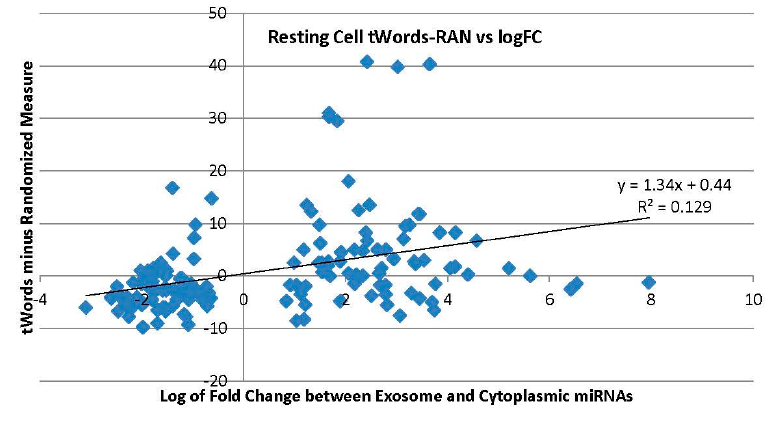
Figure 4. Resting cell miRNA tWords minus randomized sequence tWord score. Trendline added.